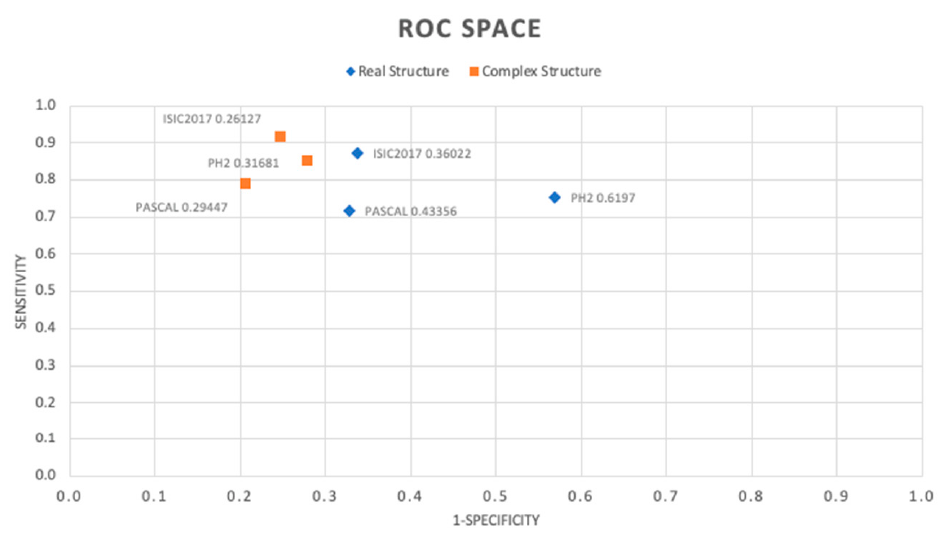
Figure 7. ROC space of the obtained classifier.